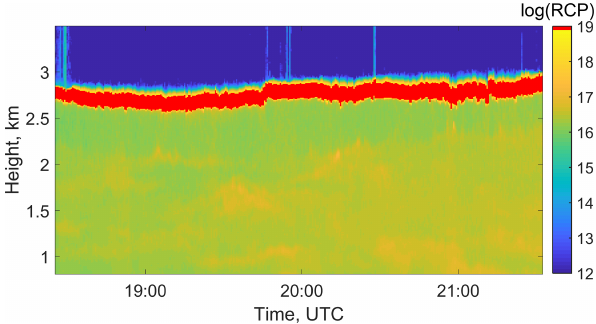
Figure 4. Range-corrected 532nm total backscatter signal (RCP) measured on 19 September 2017 with 30s and 7.5m vertical reso- lution.